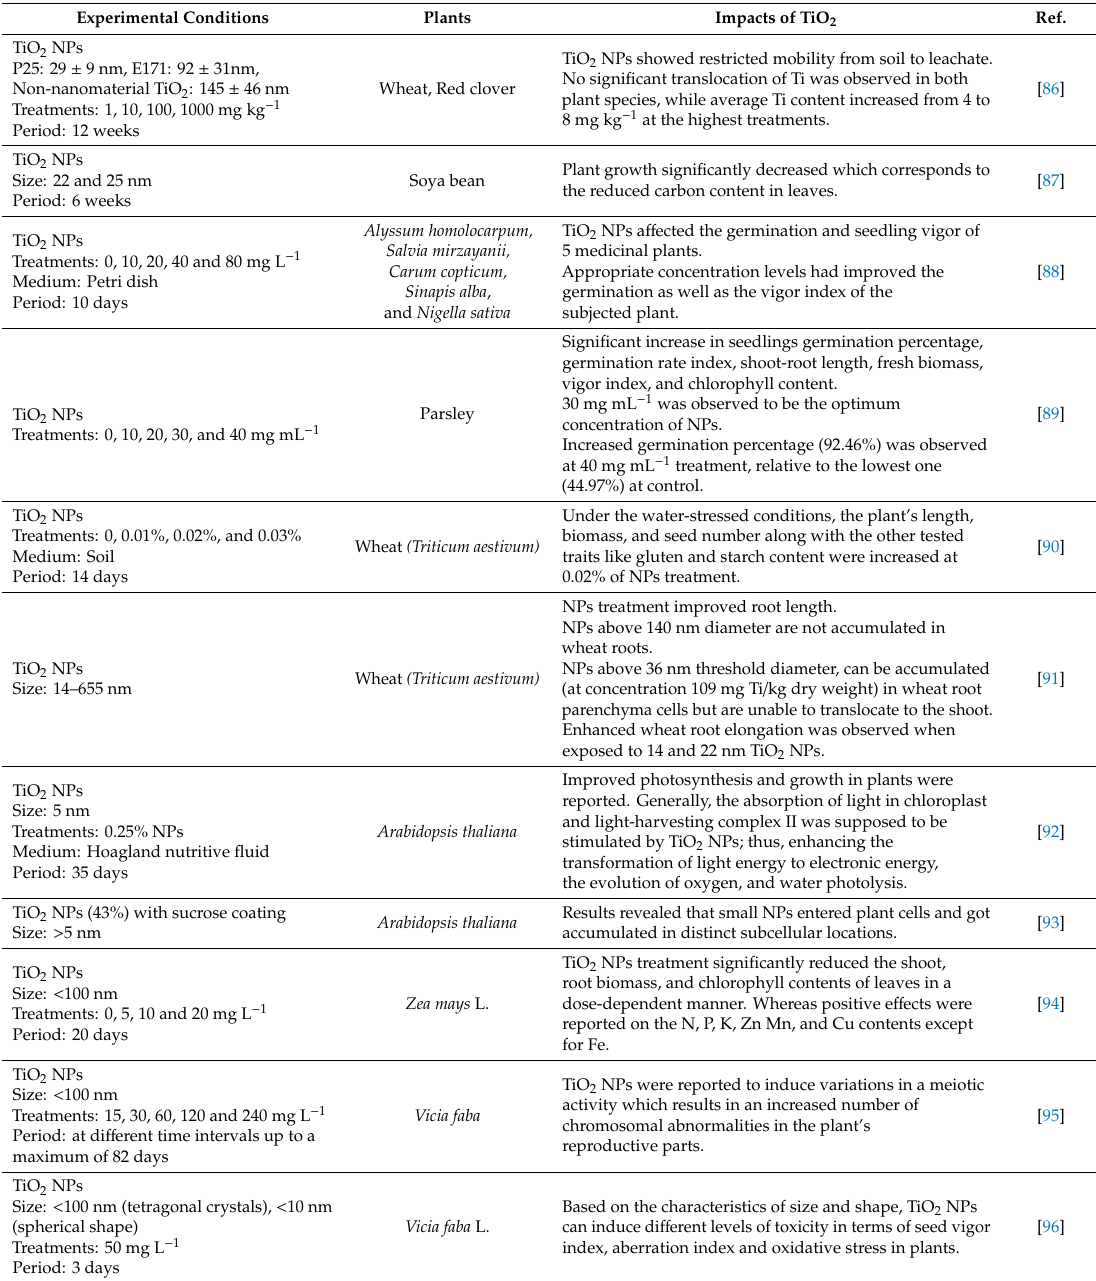
Experimental Conditions Plants Impacts of TiO 2 Ref.